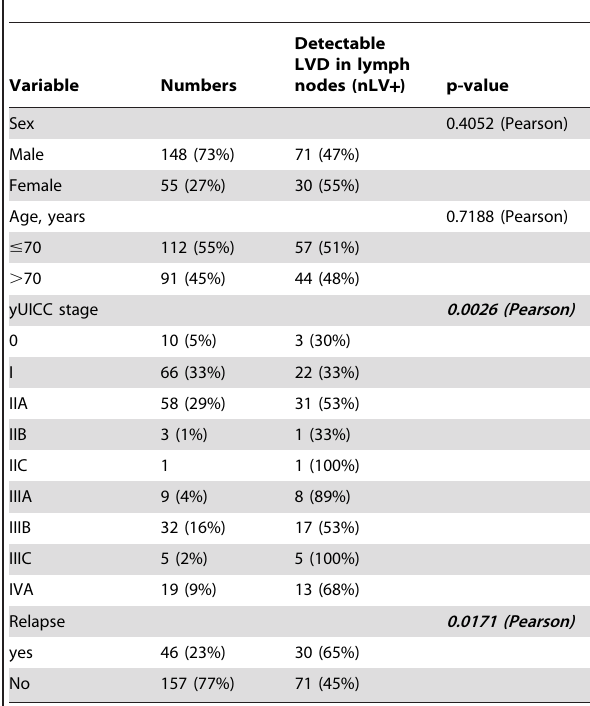
Table 1. Characterization of the evaluated cohort and the correlation of the presence of lymph node lymph vessels (nLV + ) with clinicopathological